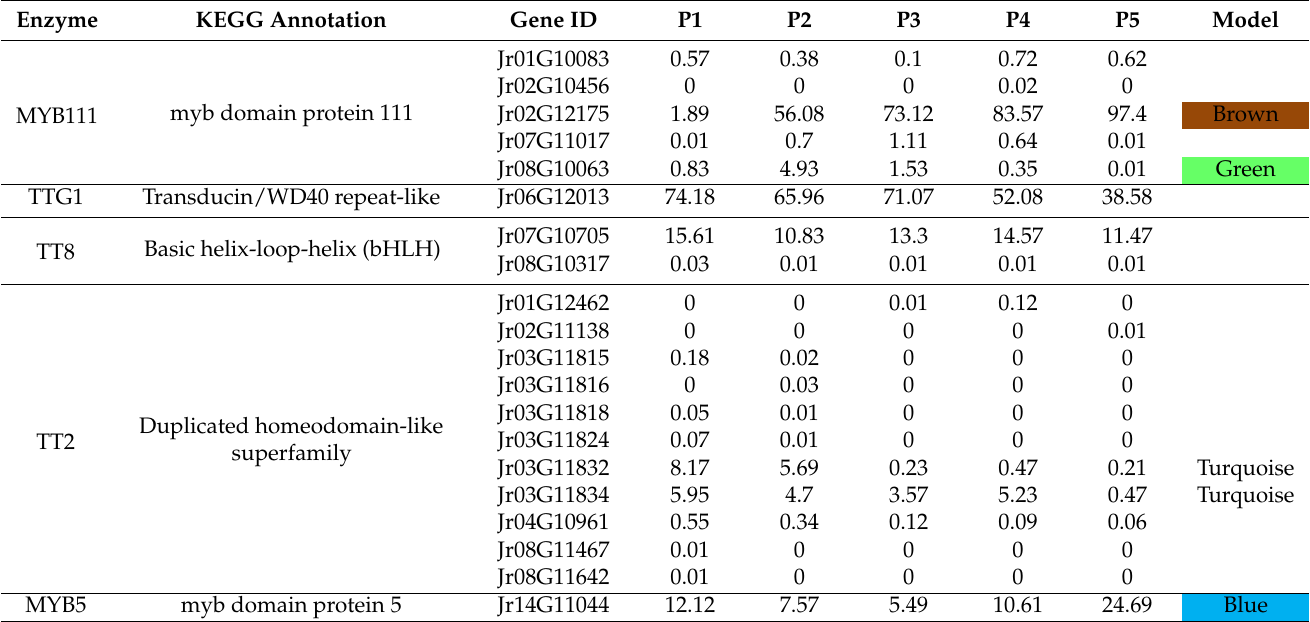
Figure 7. Regulation model for polyphenol biosynthesis by transcription factors in walnut endopleura. The descriptions of genes are listed in Table 4. The rows represent different genes encoding the same enzyme, and the five squares in each horizontal row correspond to five stages (P1, P2, P3, P4, and P5). Grey squares mean FPKM = 0. Table 4. Identification of transcription factors involved in polyphenol synthesis. The four color modules are from Figure 7.